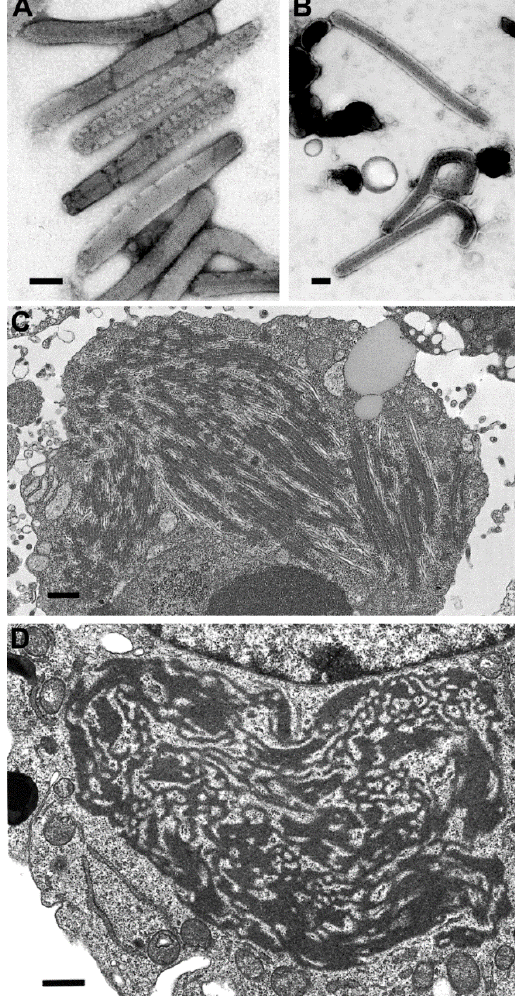
Figure 5. Negative stain images of Marburg virus ( A ) and Ebola virus ( B ), illustrating that Ebola virus has a longer length than Marburg virus. Bars, 100 nm; ( C ) Thin section